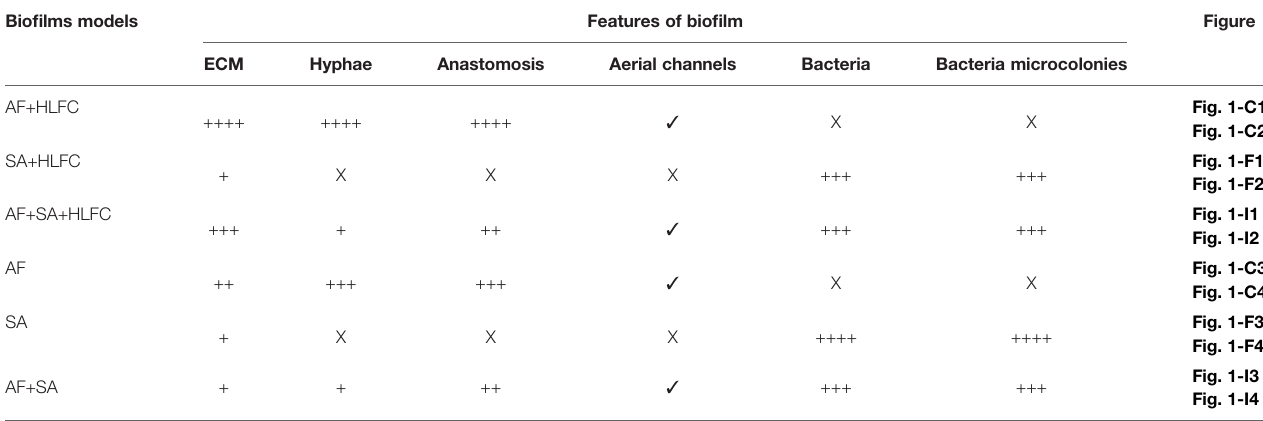
TABLE 1 | Results of the morphological analysis of bio fi lm formation over HLFCs by SEM and